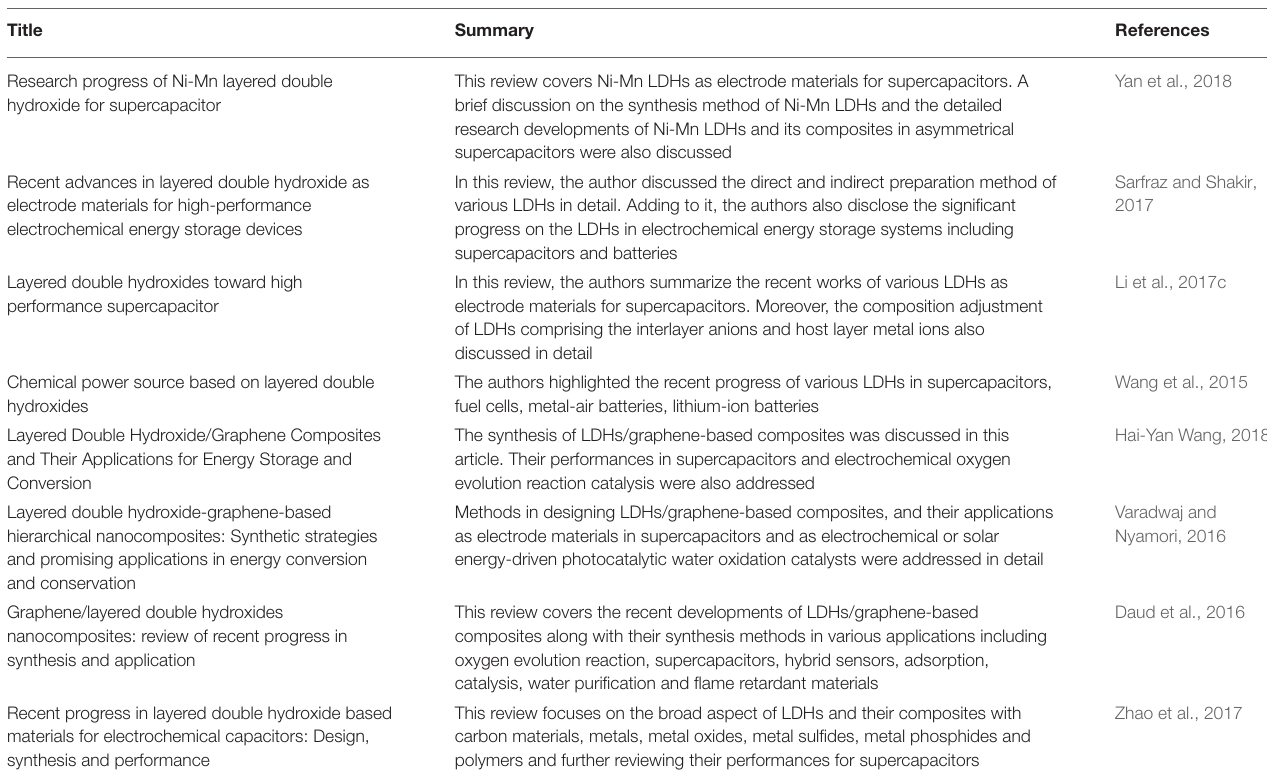
TABLE 1 | The recent reviews on layered double hydroxide for